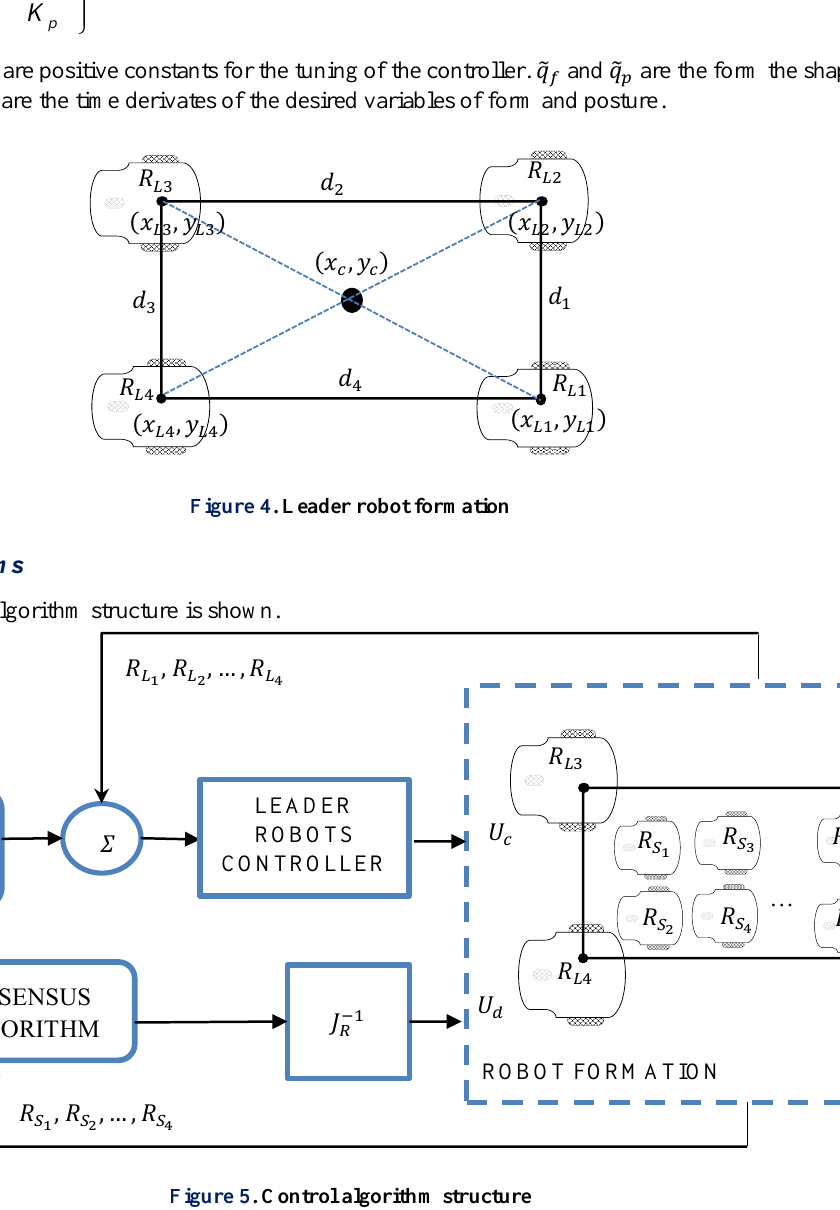
Figure 5. Control algorithm